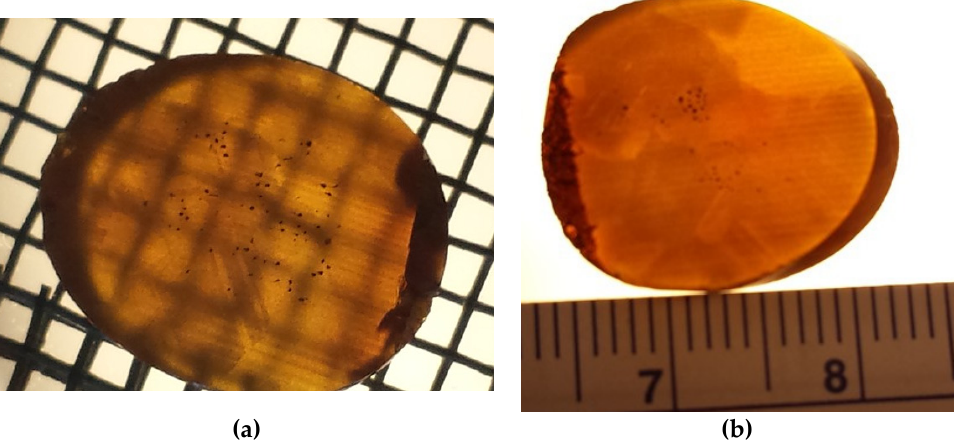
Figure 5. Bulk transparency of Fe ‐ ZnSe crystal ( a ) with and ( b ) without a wire mesh in the background. There were no voids, precipitate, or crack in the